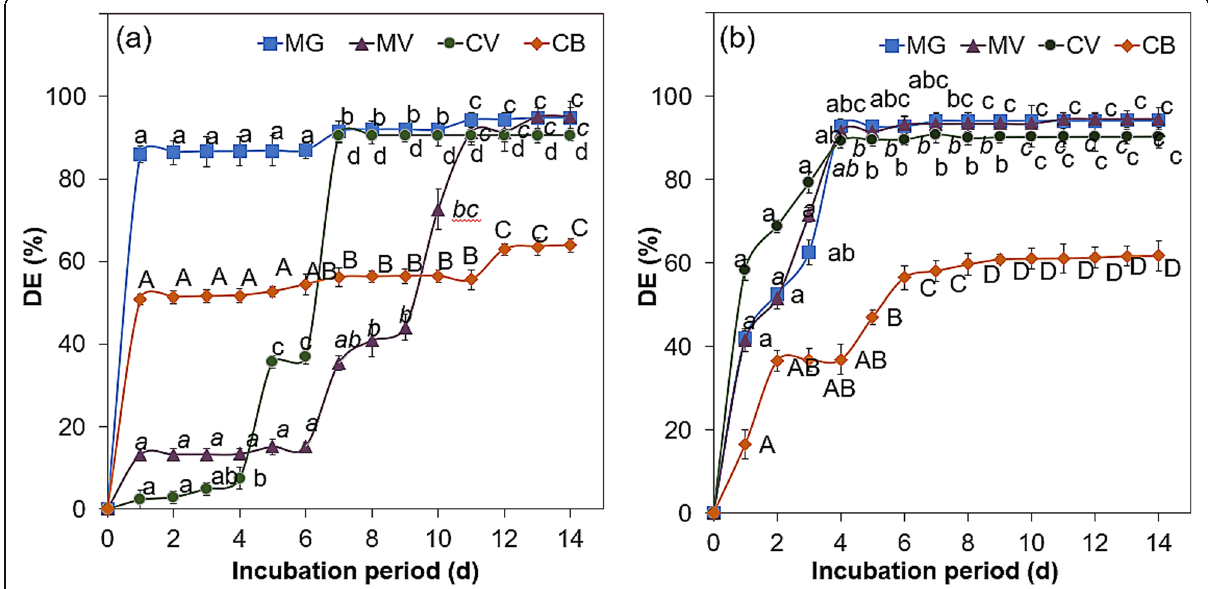
Fig. 3 Decolorization of TPM dyes by Streptomyces isolate (a) live and (b) dead cells using non-optimized conditions (biomass dosage 1.0 g, agitation 100 rpm, pH 5, incubation at 30 °C) throughout the incubation period. Means with the same letters within dye group are not significantly different at HSD ( 0.05 ). Bars indicate ±